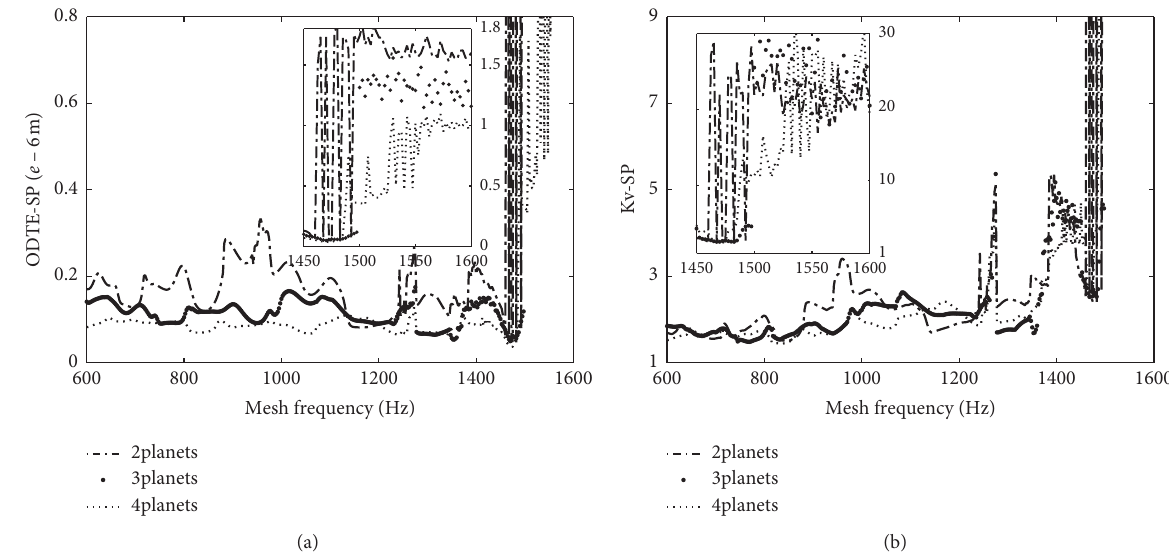
Figure 7: Influences of planet quantities. (a) Vibration characteristics of SP. (b) Load characteristics of